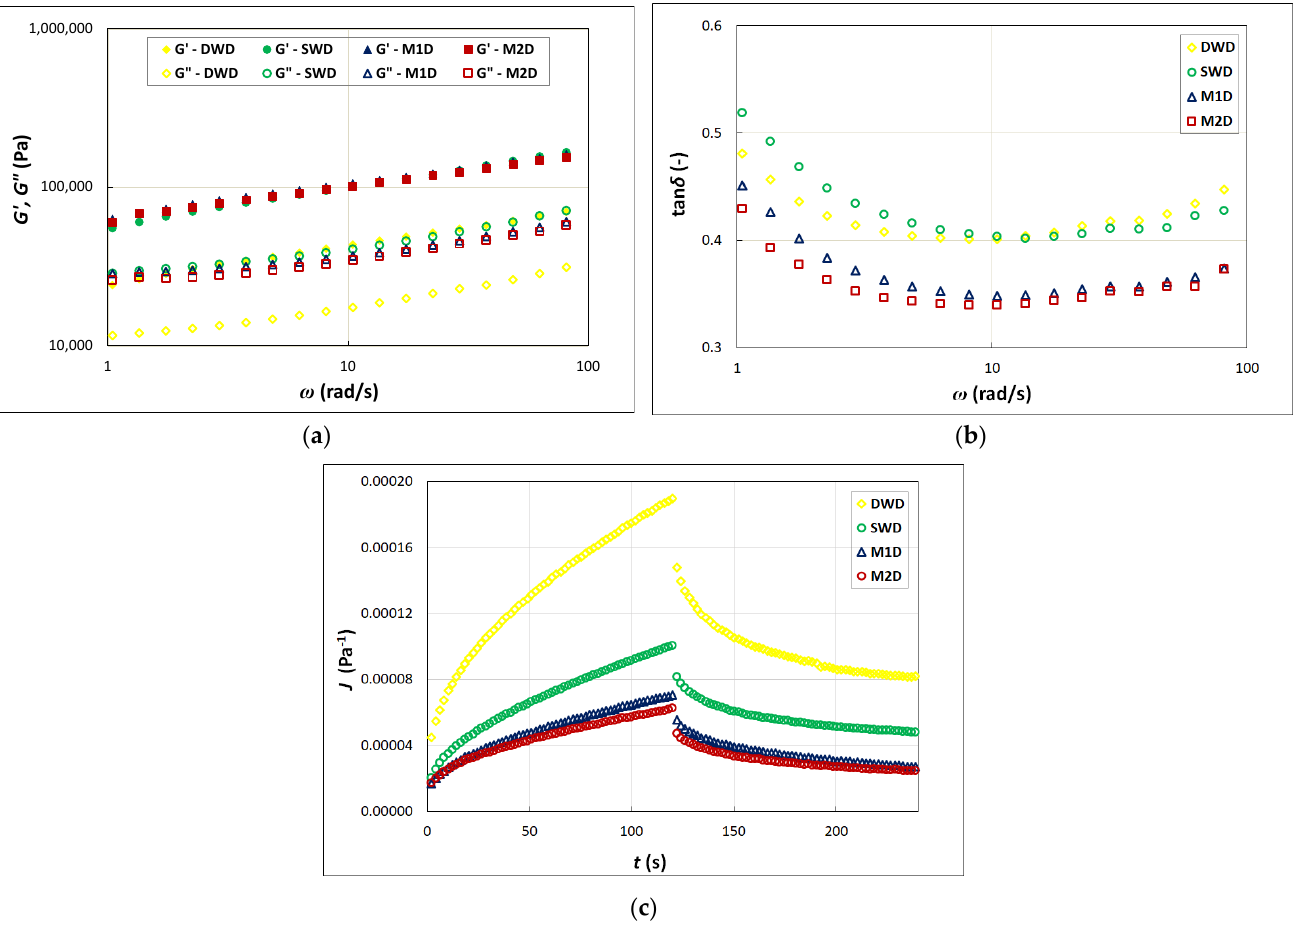
Figure 2. Rheological properties of dough: ( a ) mechanical spectra; ( b ) tangent of phase shift angle as the function of angular frequency; ( c ) creep and recovery curves. Table 3. Values for parameters describing viscoelastic properties of pasta